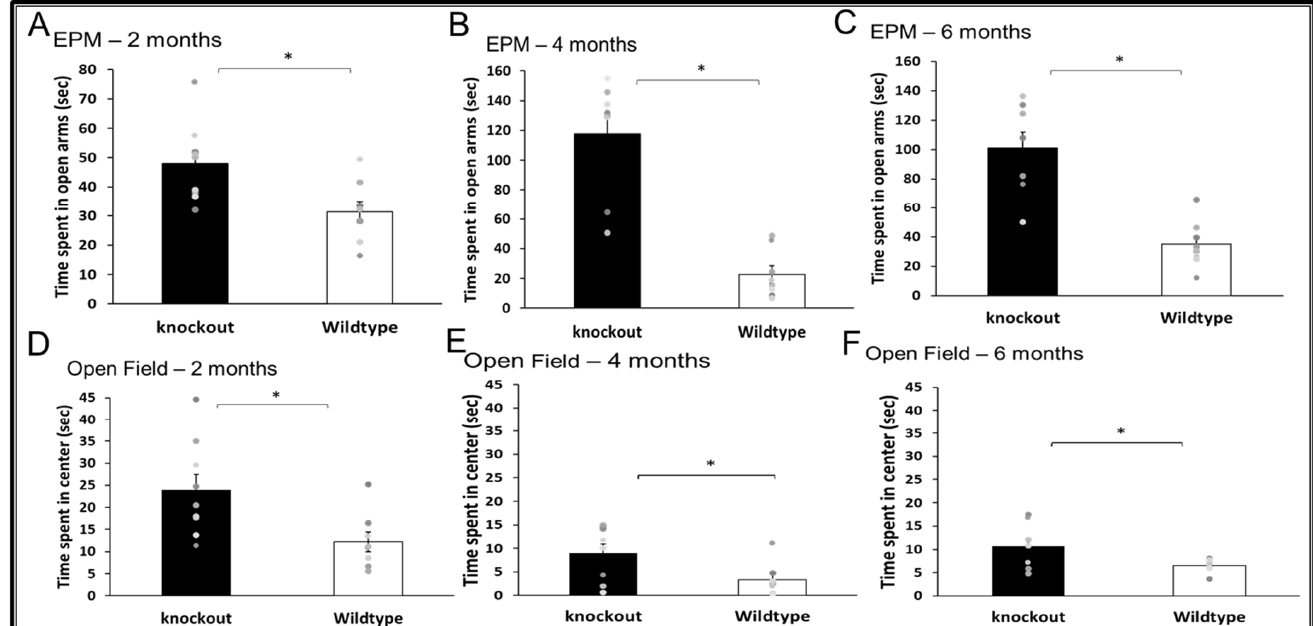
Figure 2 . The effect of CD24 knockout on anxiety-like behaviour. Abolition of CD24 reduced anxiety-like behaviour in the EPM (A-C) and Open field test (D-F), at 2 months (A and D), 4 months (B and E) and 6 months (C and F). n = 8 mice per group. * indicated p<0.05